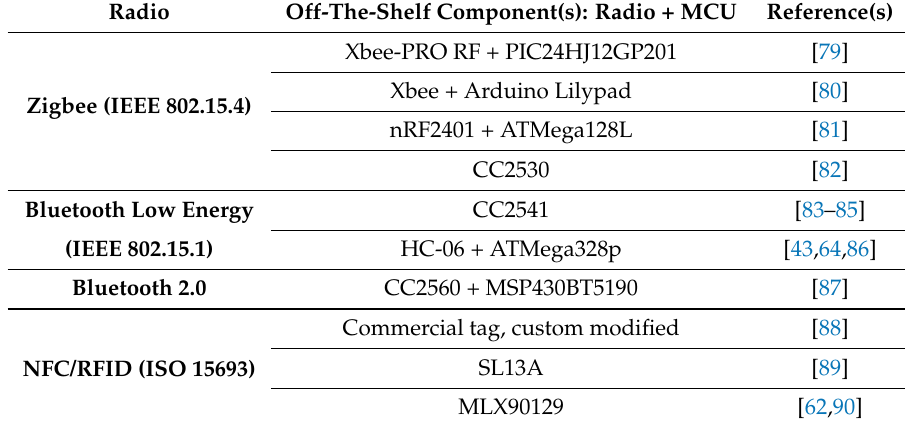
Table 2. Wireless personal area networks-radio options based on off-the-shelf components for Internet of